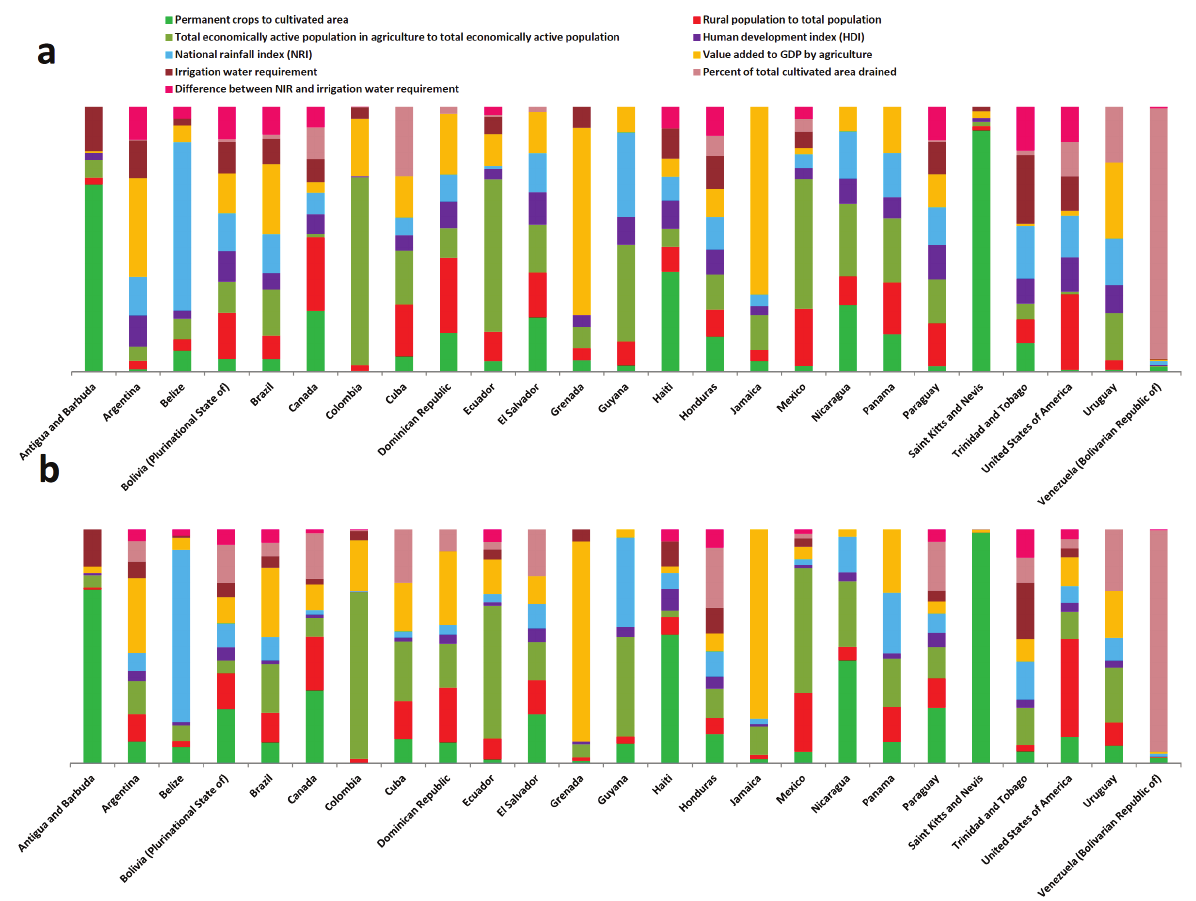
Figure 12: Role of each index to estimate value of equipped area (10th index) based on Eq. 8 (a) and Eq. 9 (b) in Americas (25 countries), the prioritization is not calculable for Bahamas, Barbados, Chile, Costa Rica, Dominica, Guatemala, Peru, Puerto Rico, Saint Lucia, Saint